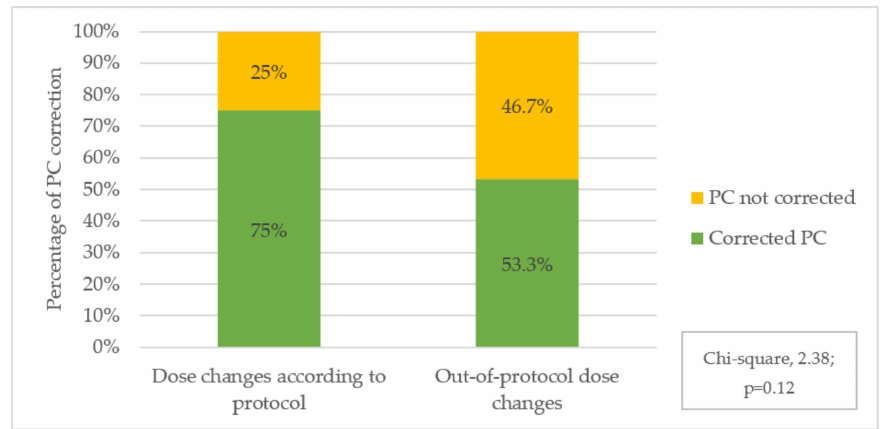
Figure 1. Voriconazole plasma concentrations (PC) corrections after dose changes according to protocol